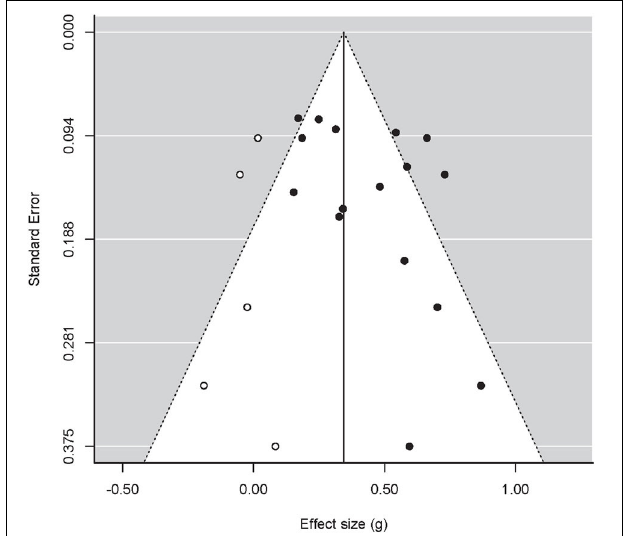
FIGURE 3 | Funnel plot for studies concerning both affects combined, with treatment effects on the x-axis and the standard error on the y-axis. Closed circles are original data, open circles represent filled-in data based on the trim-and-fill method. Dotted lines represent 95% confidence interval around the